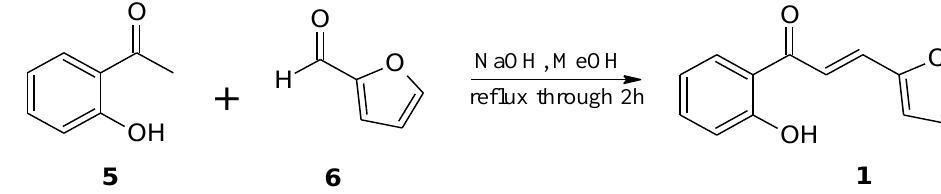
Figure 4. Synthesis of 3-(2”-furyl)-1-(2’-hydroxyphenyl)-prop-2-en-1-one ( 1 ). Molecules 2019 , 24 , x FOR PEER REVIEW